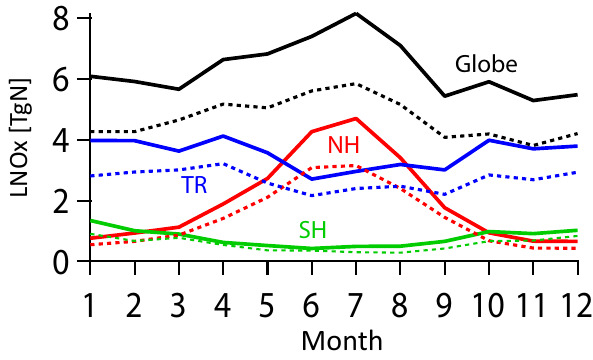
Fig. 5. Seasonal variations of the total LNO x sources (in TgN) an- alyzed from the data assimilation (solid lines) and estimated from the model simulation (dashed lines) over the globe (90 ◦ S–90 ◦ N), the Northern Hemisphere (NH, 20–90 ◦ N), the tropics (TR, 20 ◦ S–20 ◦ N), and the Southern Hemisphere (SH, 90–20 ◦ S) for 2007.